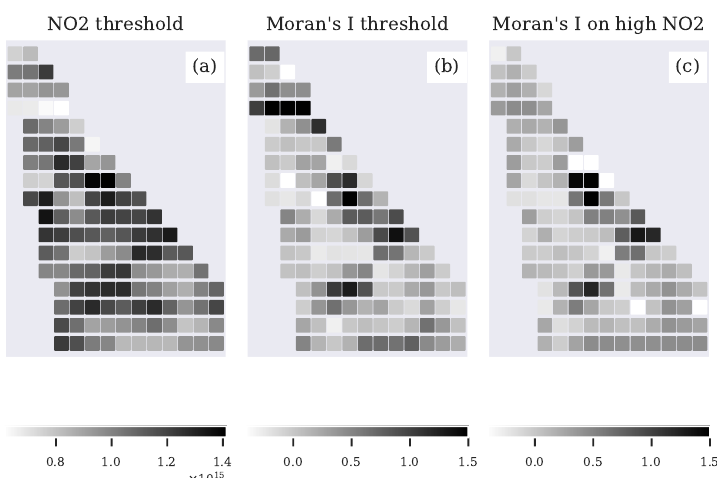
Figure 9. Input data example for univariate threshold-based benchmarks. ( a ) Input data for a benchmark method NO 2 threshold . ( b ) Input data for a benchmark method Moran’s I threshold . At the top of the ship sector , the reader can find an example when a cluster of low-value NO 2 was mistakenly enhanced by Moran’s I . ( c ) Input data for a benchmark method, Moran’s I on high NO 2 . For